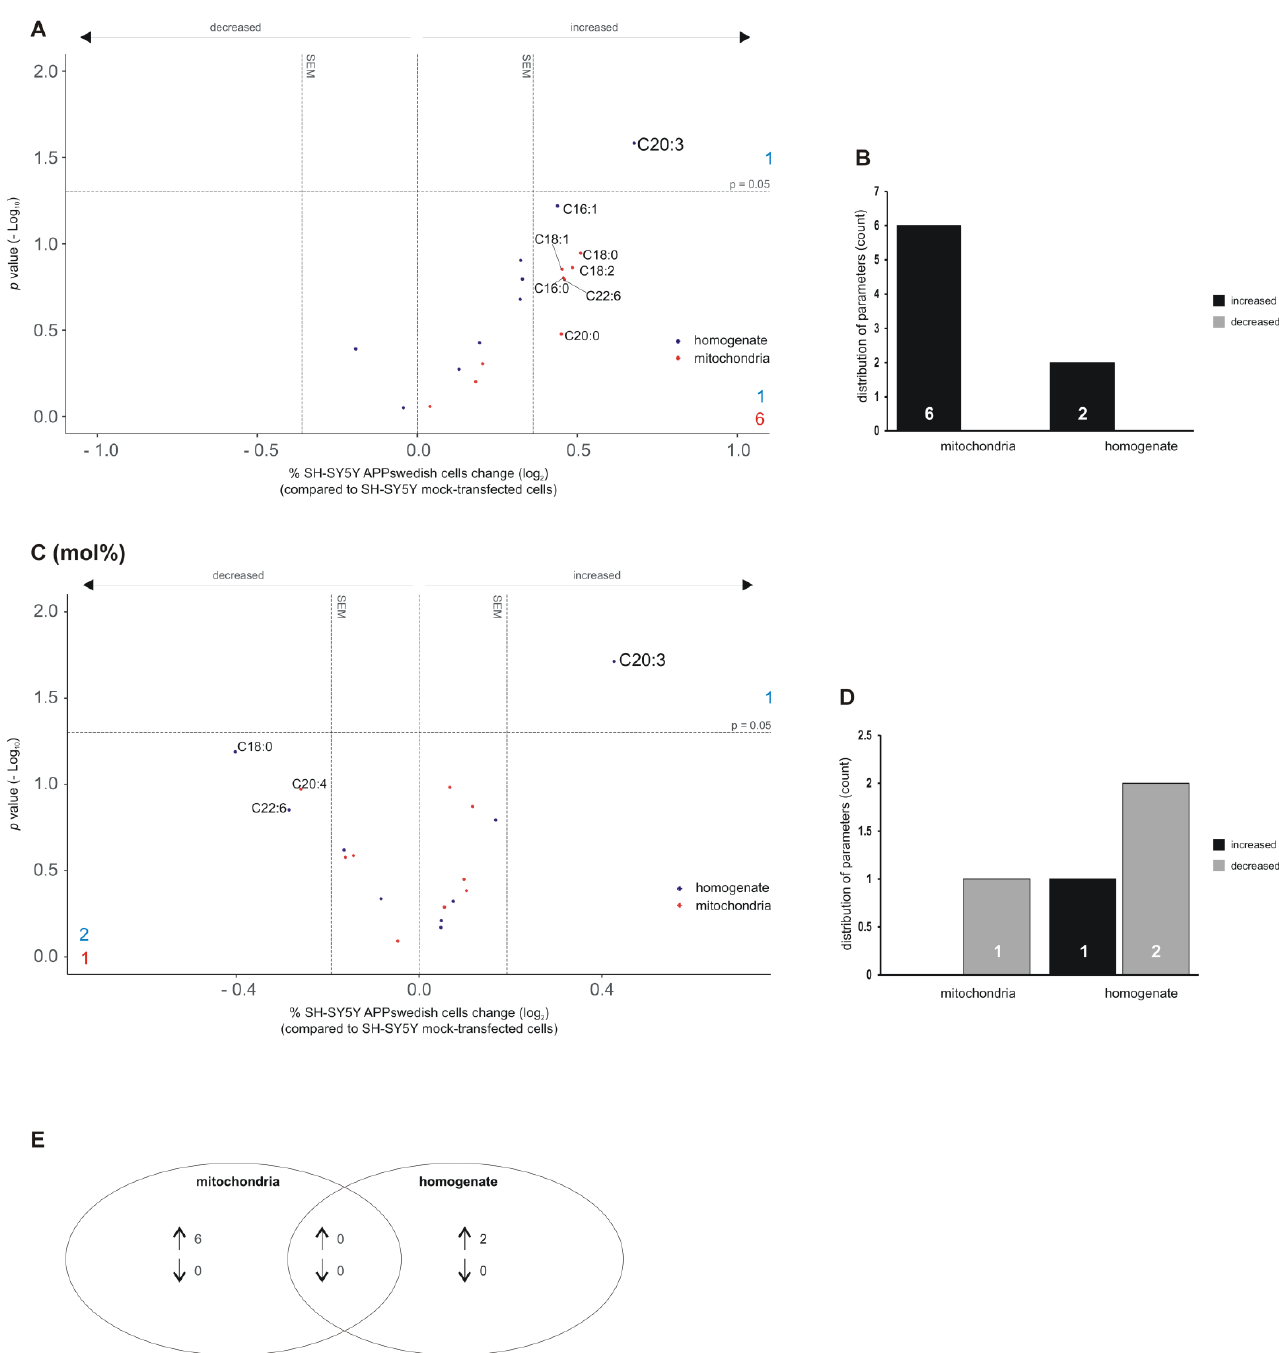
Figure 8. Changed lyso-phosphatidylethanolamine (lyso-PE) levels in homogenates and mitochondria of SH-SY5Y APPswedish cells in comparison to mock-transfected SH-SY5Y cells, respectively. ( A , B ) The fold changes of single lyso- PE species in homogenates and mitochondria are shown as volcano plots and the corresponding distribution analysis is shown in a bar chart on the right. ( C , D ) The effects of single lyso-PE species independent of lyso-PE lipid class effect are presented as appropriate volcano plot and bar chart. Vertical dashed lines next to 0.0 represent the average SEM and the horizontal dashed line marks p = 0.05 in volcano plots. Statistical significance was calculated using Fisher’s exact test. ( E ) Venn diagram showing the number of exclusively changed as well as overlapping lyso-PE species in mitochondria and homogenates in SH-SY5Y APPswedish cells compared to mock-transfected cells. Arrows indicate decreasing ( ↓ ) or in- creasing ( ↑ ) effects.